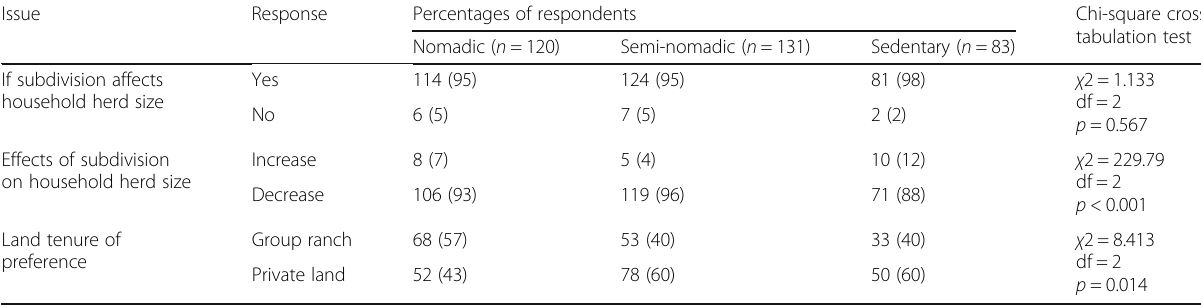
Table 4 Views of respondents on effects of land subdivision and tenure preference